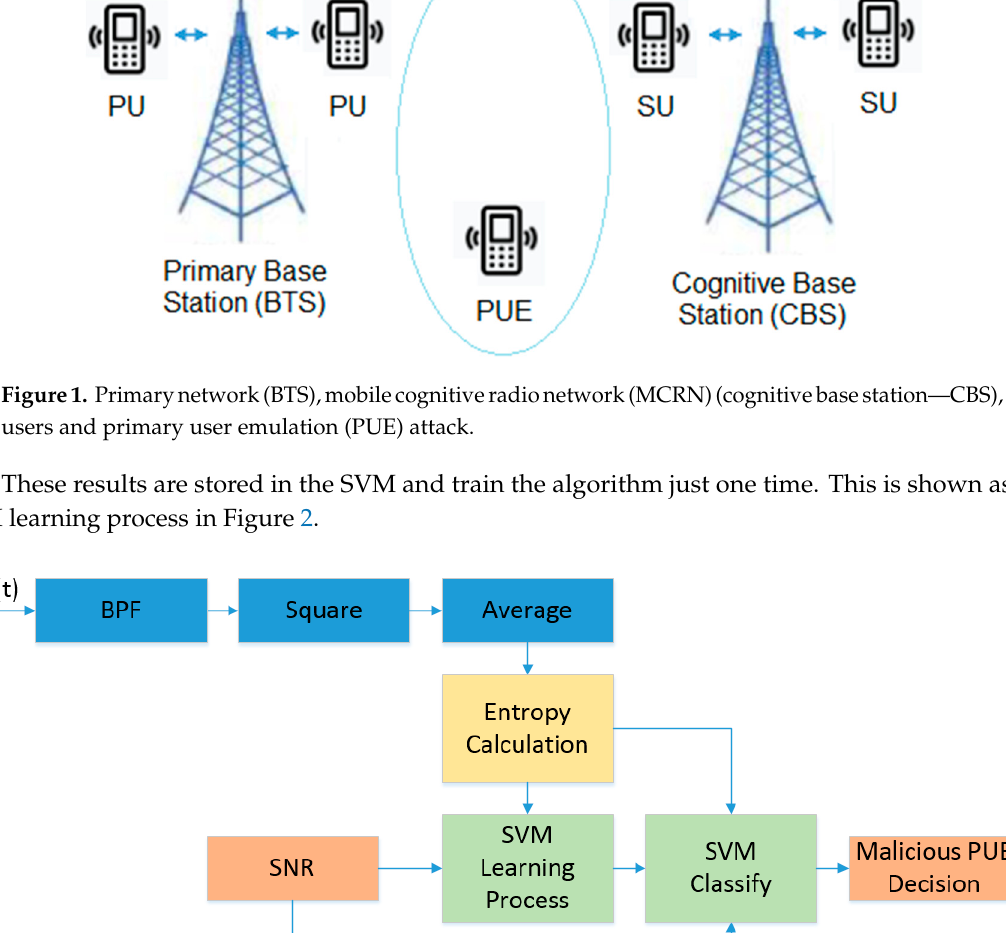
Figure 1. Primary network (BTS), mobile cognitive radio network (MCRN) (cognitive base station — CBS), users and primary user emulation (PUE) attack.